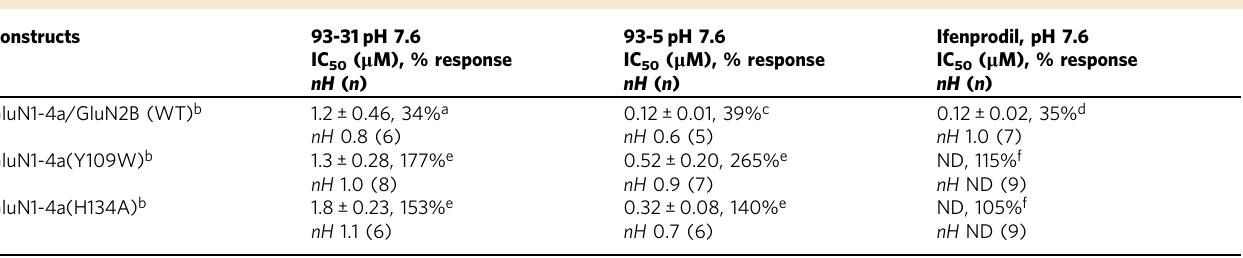
Table 3 Results of TEVC concentration – response experiments with GluN1-4a/GluN2B potentiating